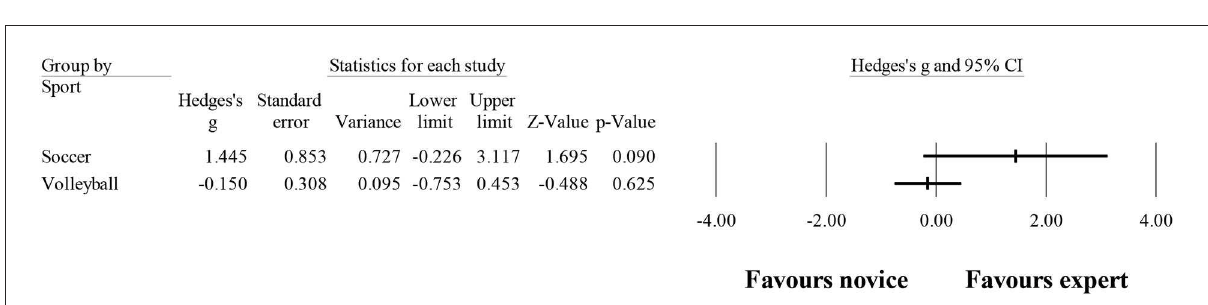
FIGURE7 Number of fixations moderated by type of sport: no significant moderator effect was noted for the type of sport ( p = 0.078 between groups).